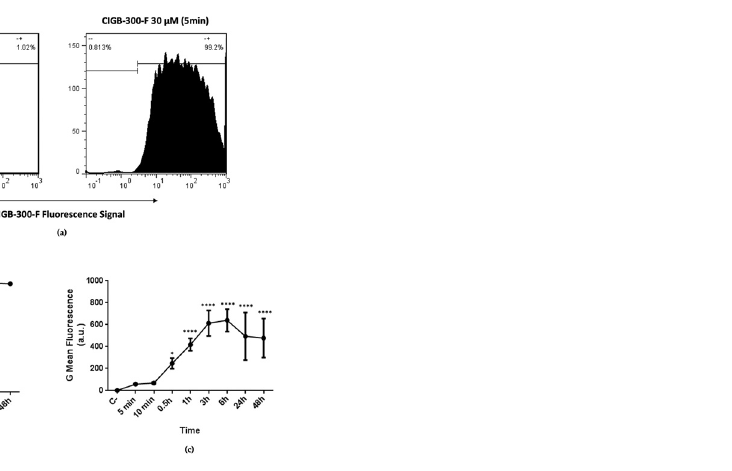
Figure 3. Internalization kinetics of CIGB-300-F in NCI-H460 cell line: ( a ) Fluorescent signal of CIGB-300-F at 30 µ M in NCI-H460 cells after 5 min of incubation vs. untreated cells; ( b ) Percent of fluorescent cells after different times of incubation with 30 µ M of CIGB-300-F; ( c ) Kinetics of intracellular accumulation of CIGB-300-F at 30 µ M. Viable cells were gated using FSC vs. SSC dot plot. Autofluorescence of untreated cells were set as threshold. Statistical comparisons were performed between each treated conditions vs. the untreated cells. Values from ( c ) are shown as mean ± SD, n = 3. (*) p -value < 0.05, (****) p -value < 0.0001.